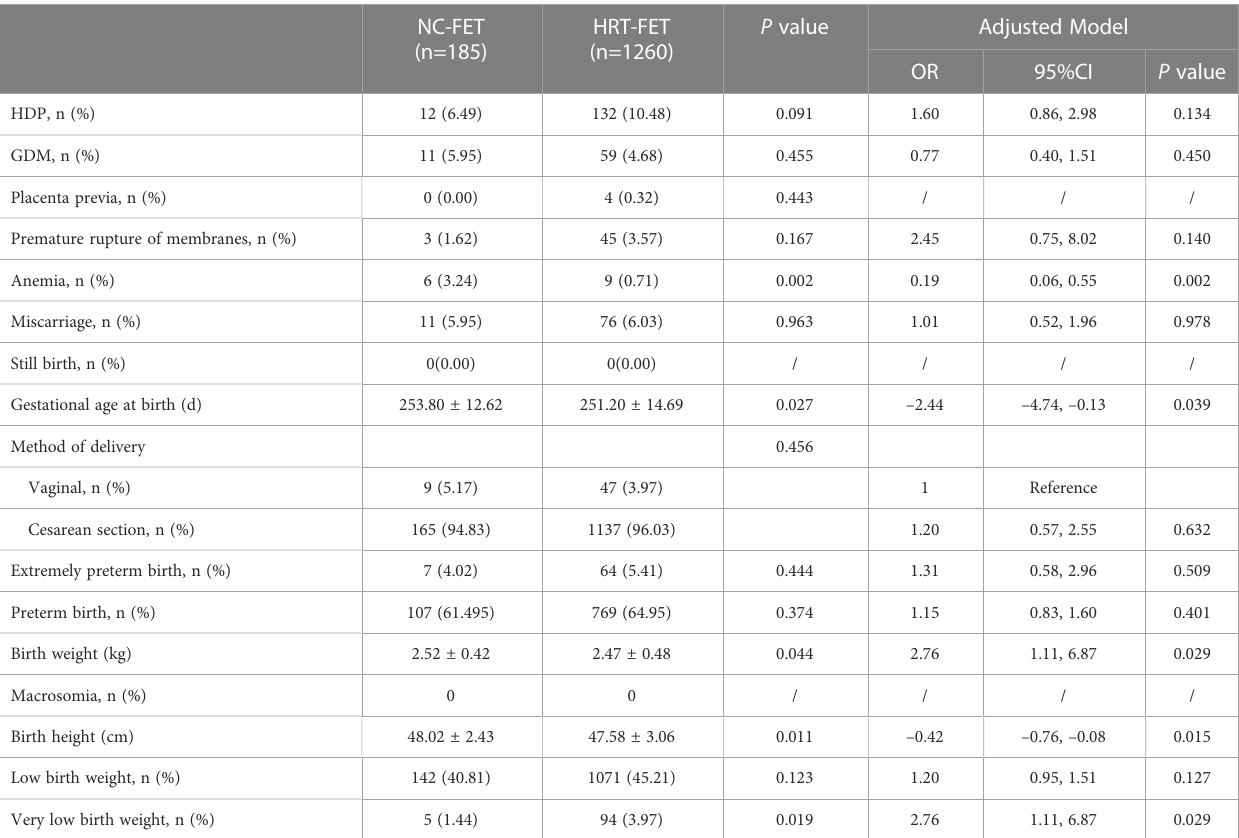
TABLE 3 Perinatal outcomes of multiple pregnancy after two different FET